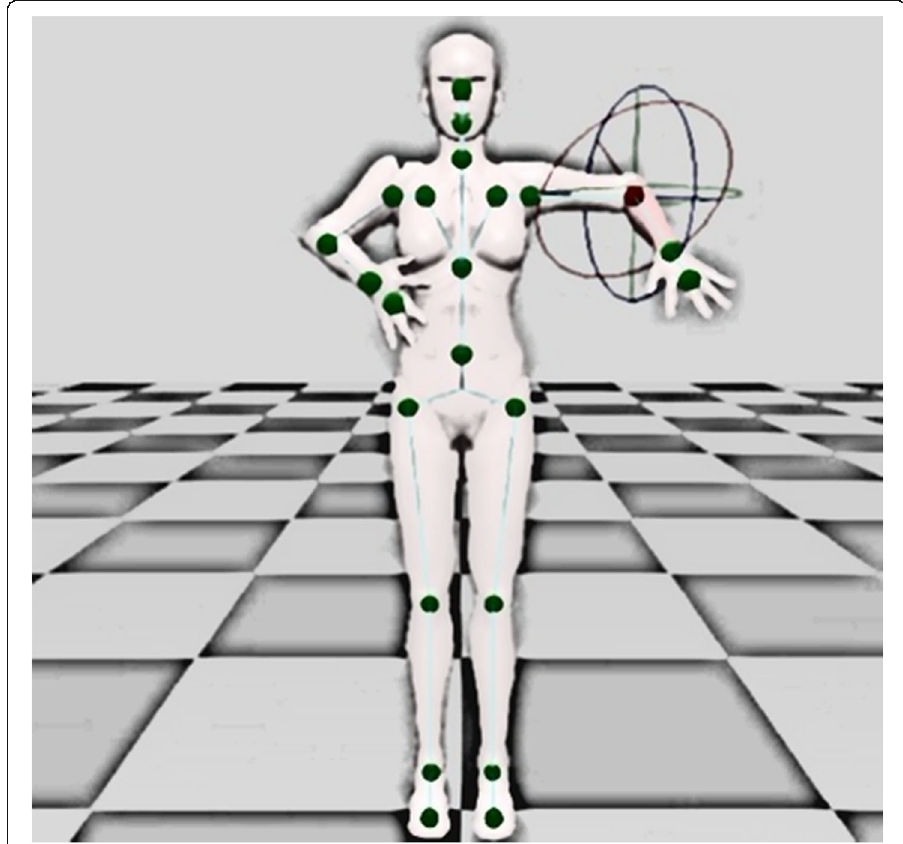
Fig. 7 Example of dynamic tracking of human joint node